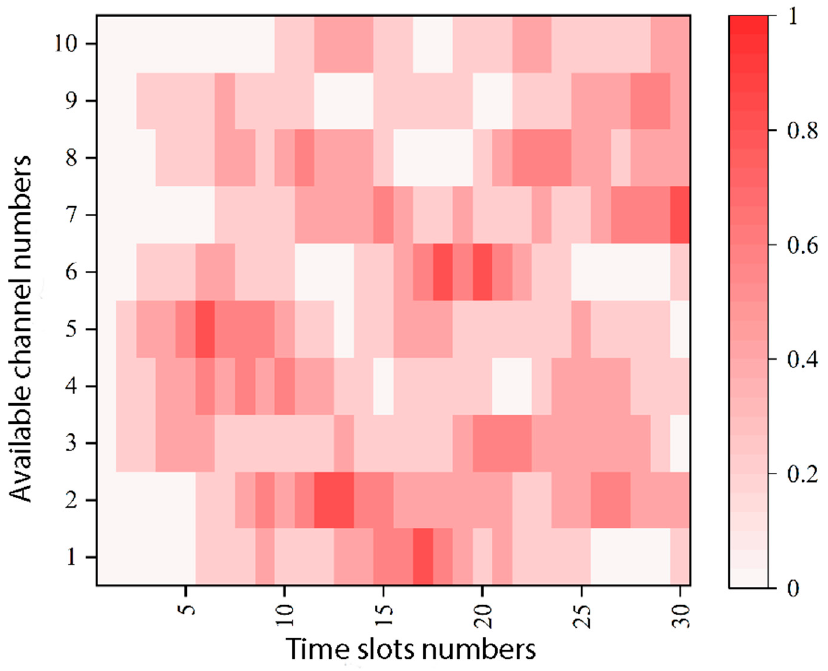
Figure 6. Thermal diagram of intelligent tracking sub-jamming time slot-channel probability distri- bution.